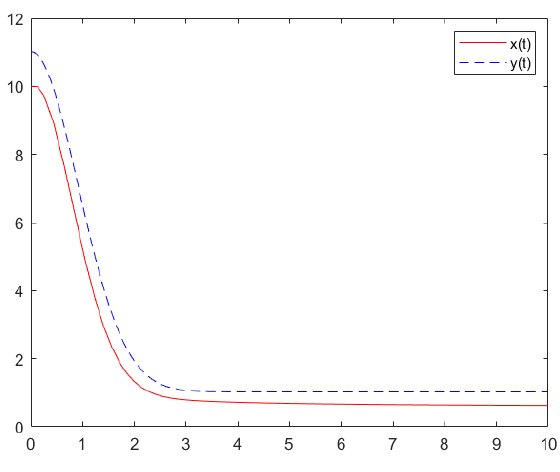
Figure 2. The graph of function x ( t ) and y ( t ) (Example